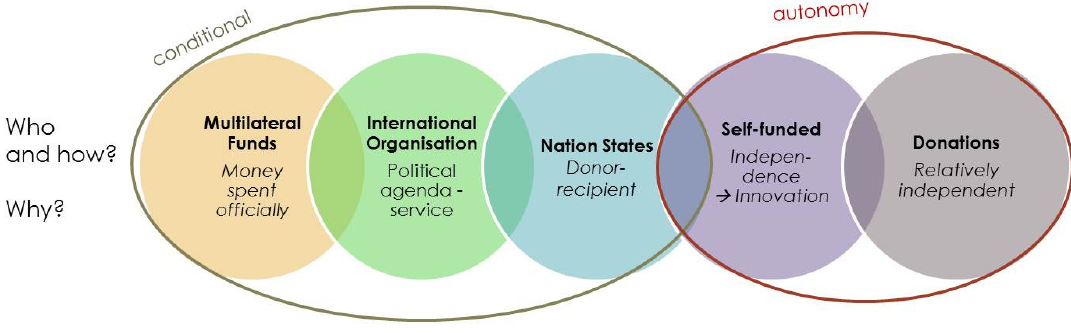
Figure 3. Financial roles.